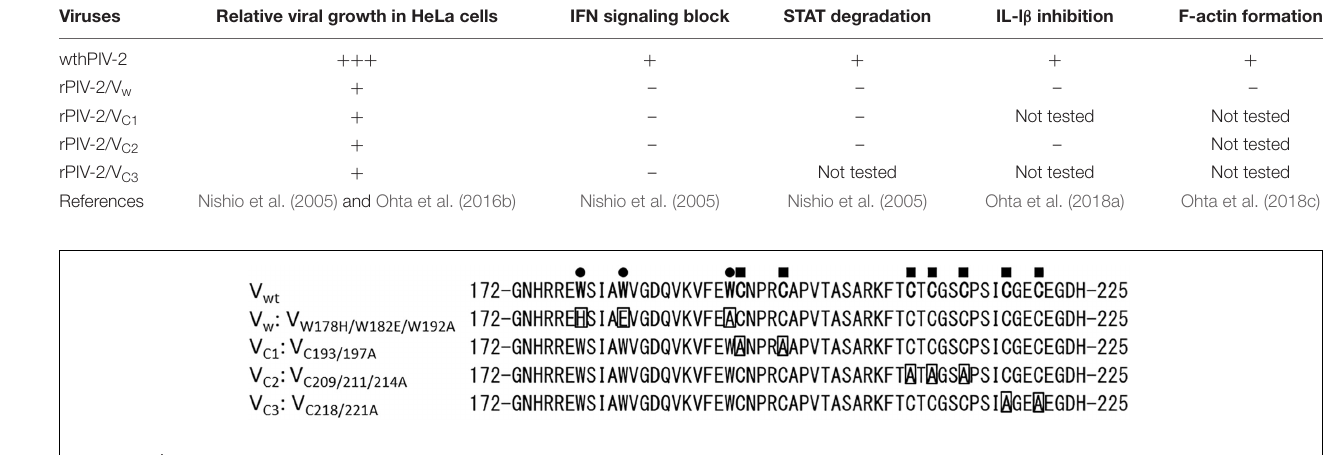
TABLE 1 | Summary of the properties of wt hPIV-2 and rPIV-2 carrying V mutants. Viruses